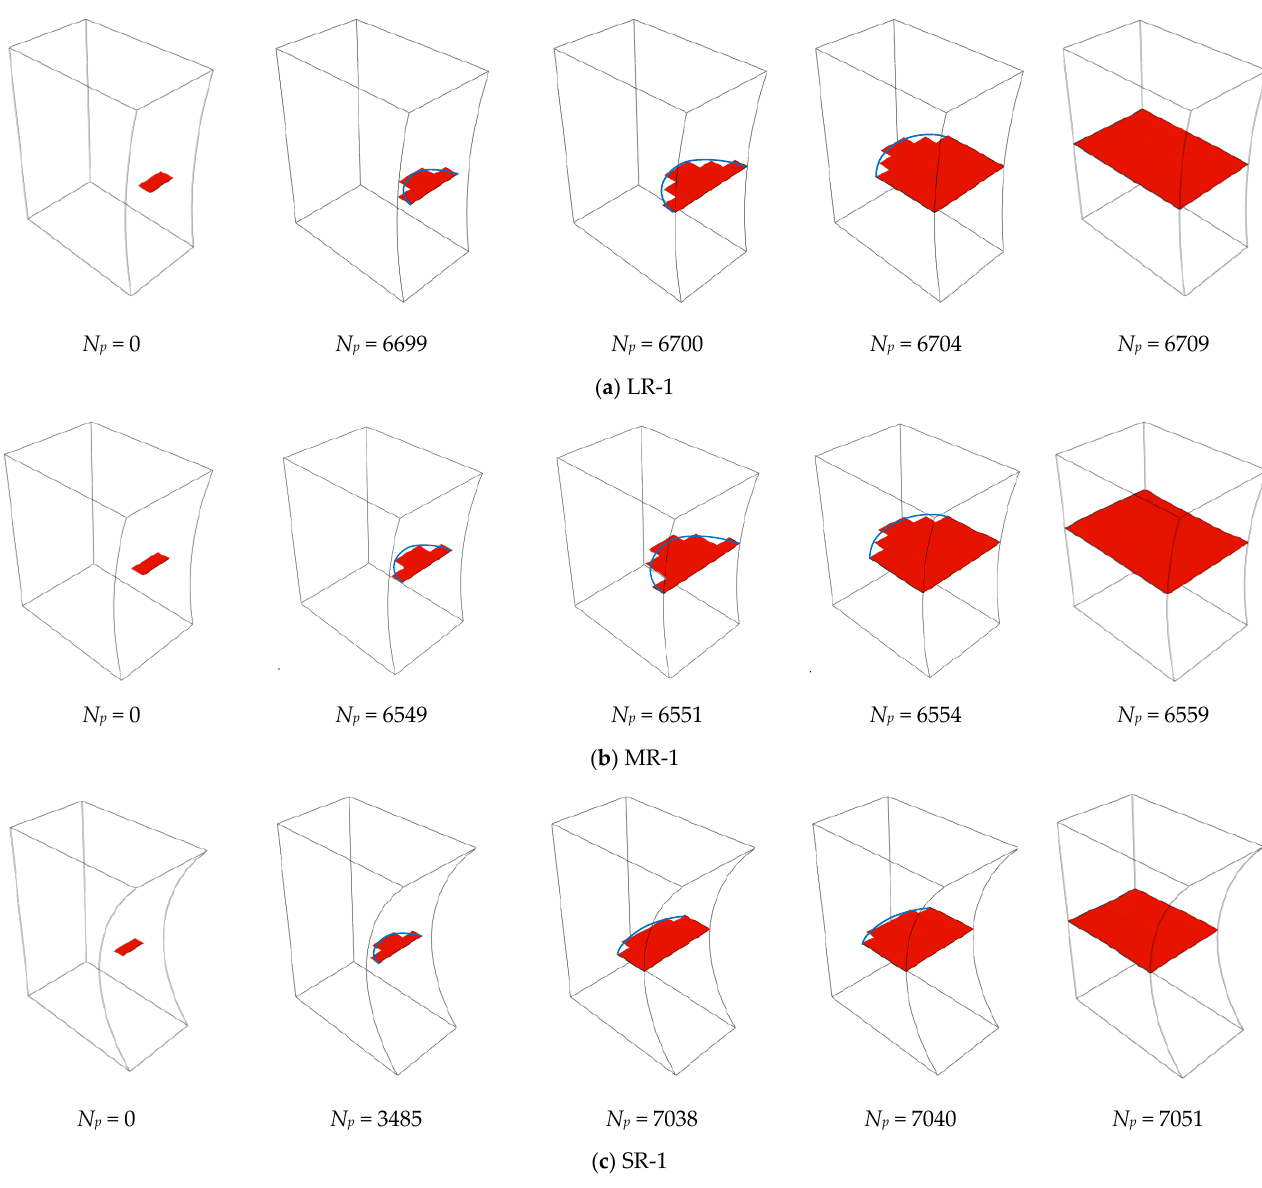
Figure 10. Simulated evolutions of the fatigue crack surface.